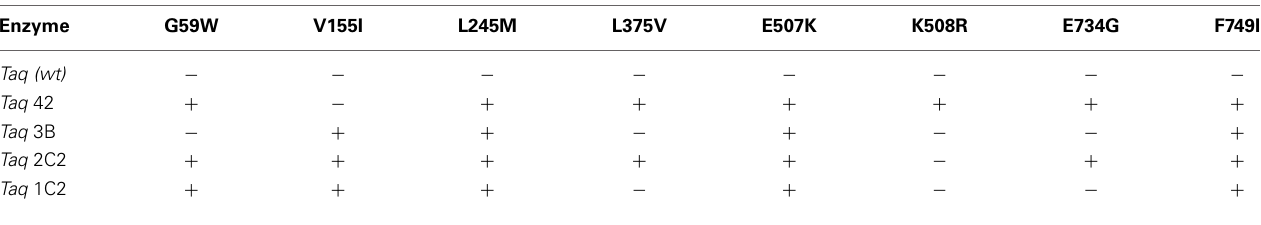
Table 1 | Taq mutations. Enzyme